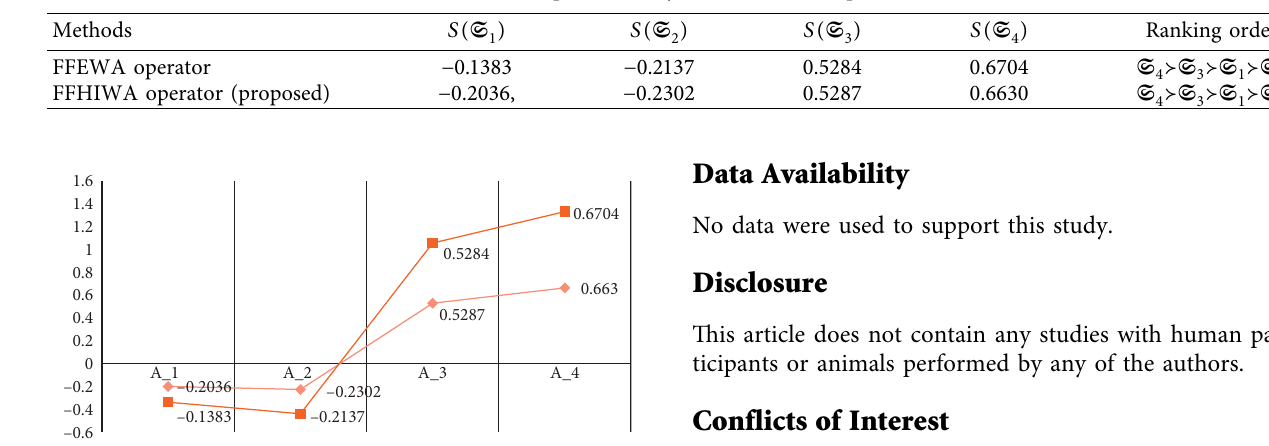
Table 5: Comparison analysis with FFEWA